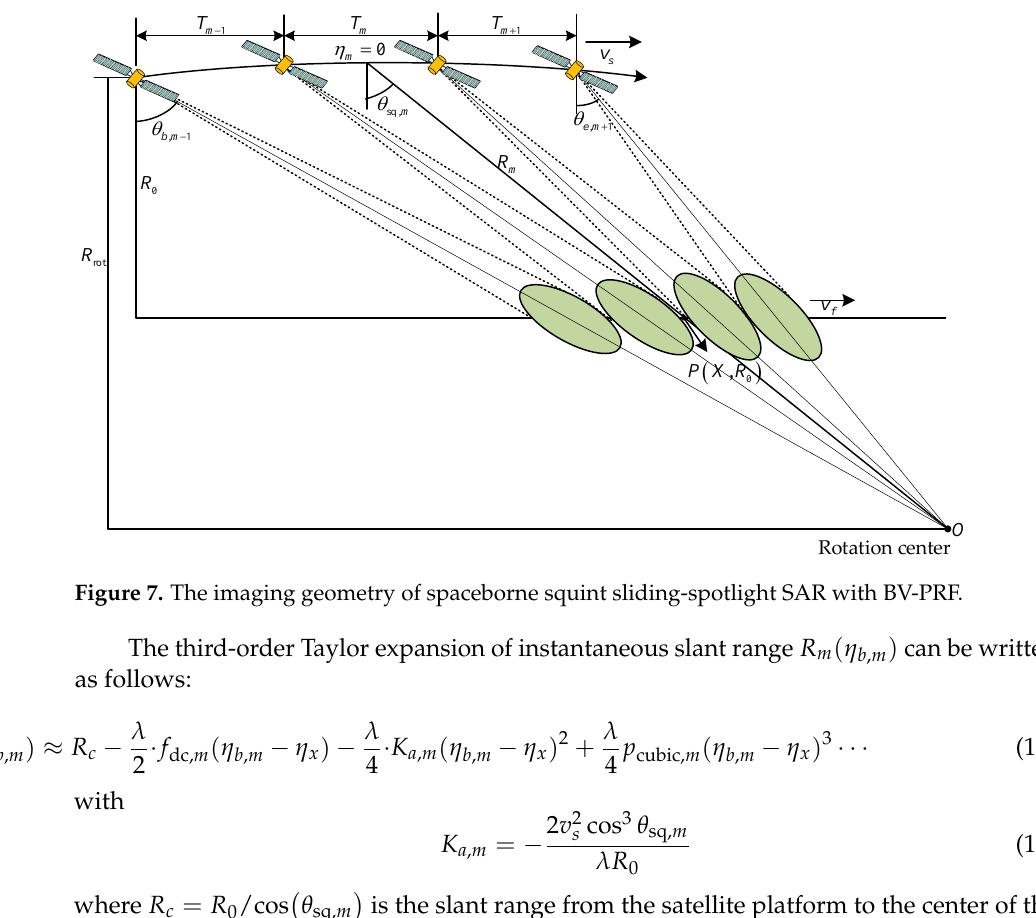
Figure 6. Echo simulation with different pulse transmission sequences. ( a ) Scene distribution of tar- gets; ( b ) the fixed PRF; ( c ) the CV-PRF; ( d ) the BV-PRF.